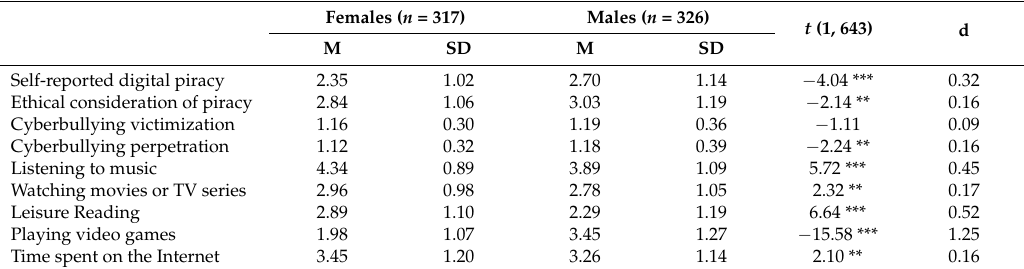
Table 2. Gender differences in all the study